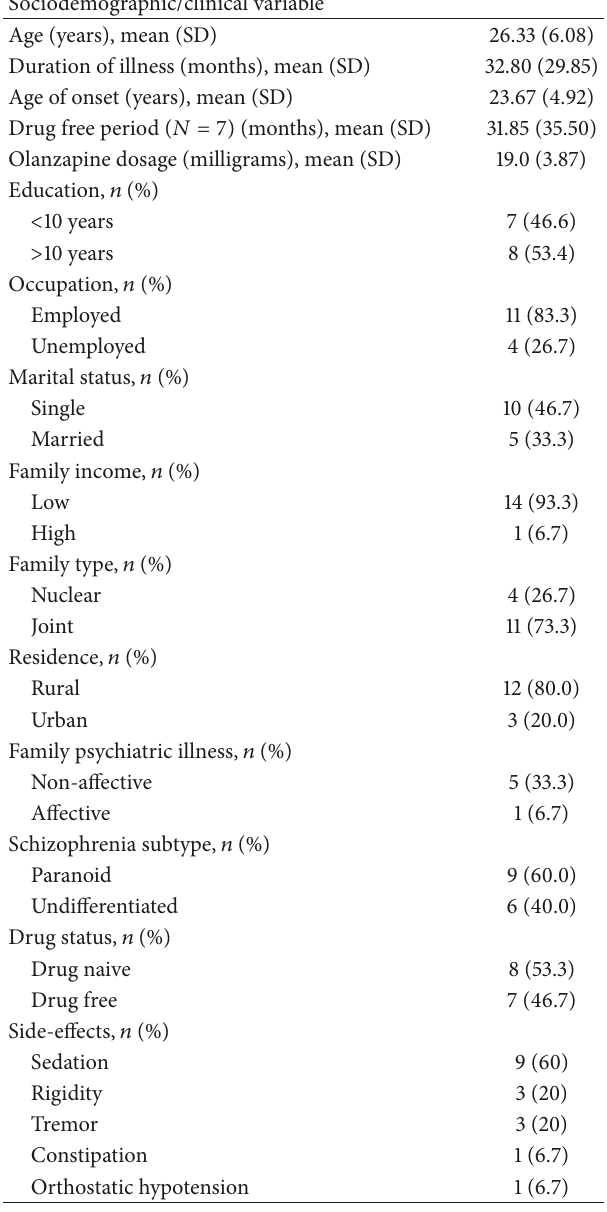
Table 1: Sociodemographic and clinical characteristics of the patients ( 𝑁 = 15